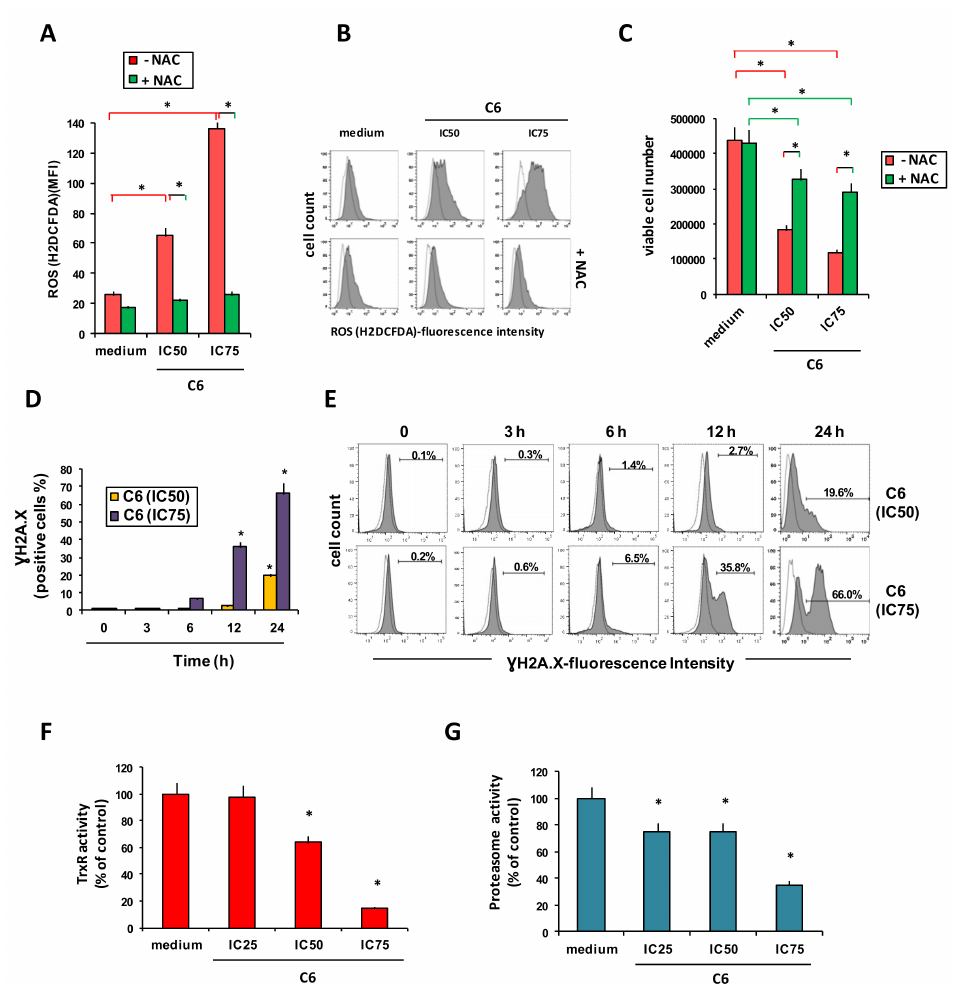
Figure 3. Compound C6 increases ROS generation induces double-stranded DNA breaks and reduces thioredoxin reductase and 20 S proteasome activities. PC3 cells were cultured in complete medium alone or with compound C6 , at the half-maximal inhibitory concentration (IC 50 ), at IC 25 , or IC 75 . ( A , B ) Reactive oxygen species (ROS) generation by PC3 cells exposed to C6 at IC 50 and IC 75 for 24 h, in the presence or absence of the ROS scavenger N-acetyl cysteine (NAC) (added 30 min before drug treatment). ROS were detected using H2DCFDA. ( A ) Generated ROS levels (mean fluorescence intensity, MFI). ( B ) Representative flow cytometry histograms of generated ROS. ( C ) Number of viable cells 24 h after treatment with C6 and NAC (NAC, added 30 minutes before drug treatment), evaluated using trypan blue dye exclusion. ( D , E ) Histone H2A.X phosphorylation ( γ H2A.X) as a measure of double-stranded DNA breaks, detected with FITC anti-H2A.X Phospho (Ser139) antibody. ( D ) Time course of phosphorylation at two concentrations of C6 . ( E ) Representative flow cytometry histograms of γ H2A.X. ( F ) Thioredoxin reductase (TrxR) activity after a 12 h treatment with C6 , normalized to control (medium). ( G ) Proteasome activity after a 12 h treatment with C6 , evaluated with the 20S-Proteasome Assay kit, normalized to control (medium). All bar charts report means and SD of three independent experiments. Statistical analysis was performed using one-way ANOVA, followed by Turkey’s or Dunnett’s multiple comparisons test where appropriate. * p < 0.05 vs. medium, unless otherwise